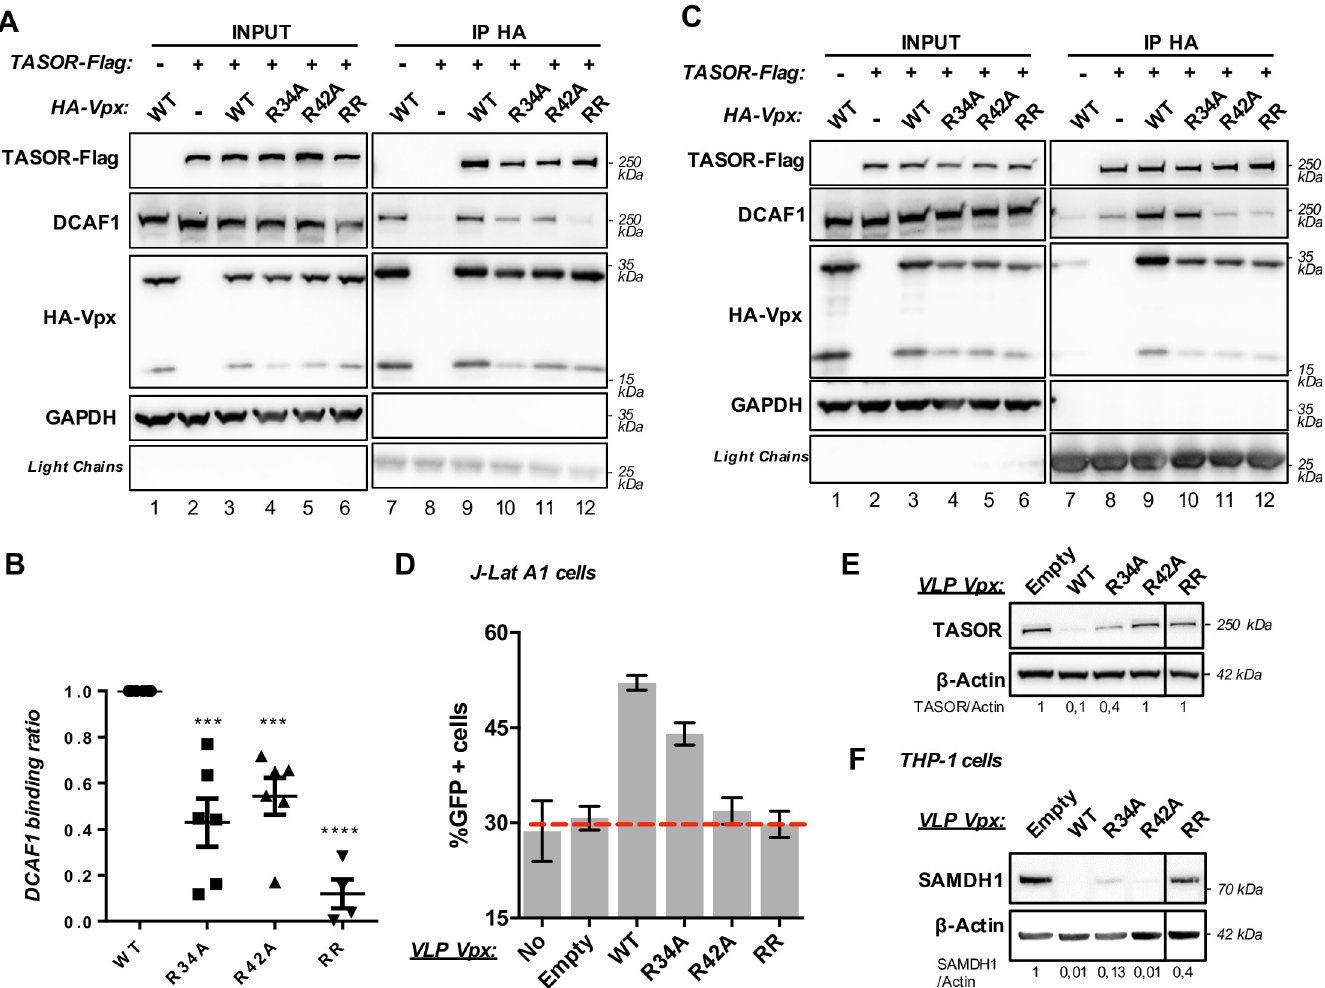
Fig 5. Vpx R34A-R42A, which induces SAMHD1 but not TASOR degradation, is characterized by a reduced binding affinity for DCAF1. ( A ) HA-Vpx WT or indicated mutants and TASOR-Flag were co-expressed in HeLa cells, then an anti-HA immunoprecipitation was performed. ( B ) Graph representing Vpx binding affinity to DCAF1. Co-immunoprecipitated DCAF1 and immunoprecipitated HA-Vpx (Vpx WT (n = 6), Vpx R34A (n = 6), R42A (n = 6) and RR (n = 4)) were quantified from independent experiments. Co-immunoprecipitated DCAF1 signal over immunoprecipitated Vpx signal ratios were calculated and reported to Vpx WT (ratio 1). ( C ) TASOR-Flag and HA-Vpx WT or indicated mutants were co-expressed in HeLa cells, then an anti-Flag immunoprecipitation was performed. Immunoblot is representative of at least 3 independent experiments. ( D and E ) HIV-2.Gh1 Vpx WT and mutants were tested for viral reactivation ( D ) and TASOR degradation ( E ). J-Lat A1 T cells were treated with VLPs. After overnight treatment with TNF- α , HIV-1-LTR-driven GFP expression was analyzed by flow cytometry and whole-cell extracts were analyzed by western blot. For each mutant, reactivation assay was tested at least 3 times (SEM is shown), and immunoblots are representative of at least 3 independent experiments. ( F ) HIV-2.Gh1 Vpx WT and mutants were tested for SAMDH1 degradation, THP-1 cells were treated with VLP overnight and then whole-cell extracts were analyzed by western blot. RR : Vpx double mutant R34A-R42A. For each mutant, immunoblots are representative of 3 independent